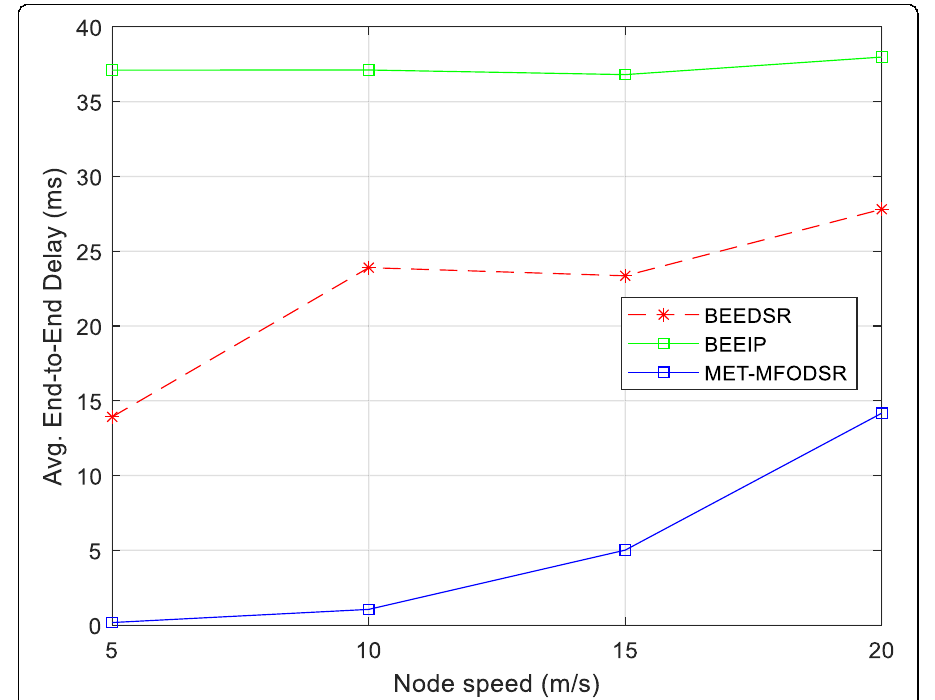
Fig. 10 Average end-to-end delay simulation results for BEEDSR, BeeIP, and MET-MFODSR. The simulation results of the average delay under the node speed